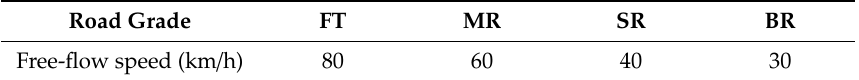
Table 5. Free-Flow Speed in Di ff erent Urban Road Hierarchies.